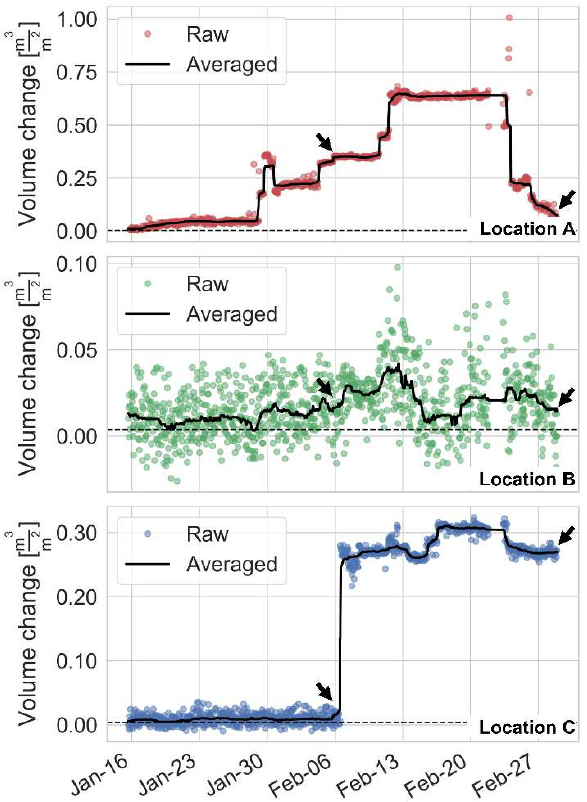
Figure 7. Time series of volume change at locations A-C (Fig. 6). Black arrows mark the points in time of the three- and six-week period. Raw values are visualized together with the re- sult of the temporal averaging. The dashed line marks the align- ment accuracy derived for the entire time series. Vertical axes have different